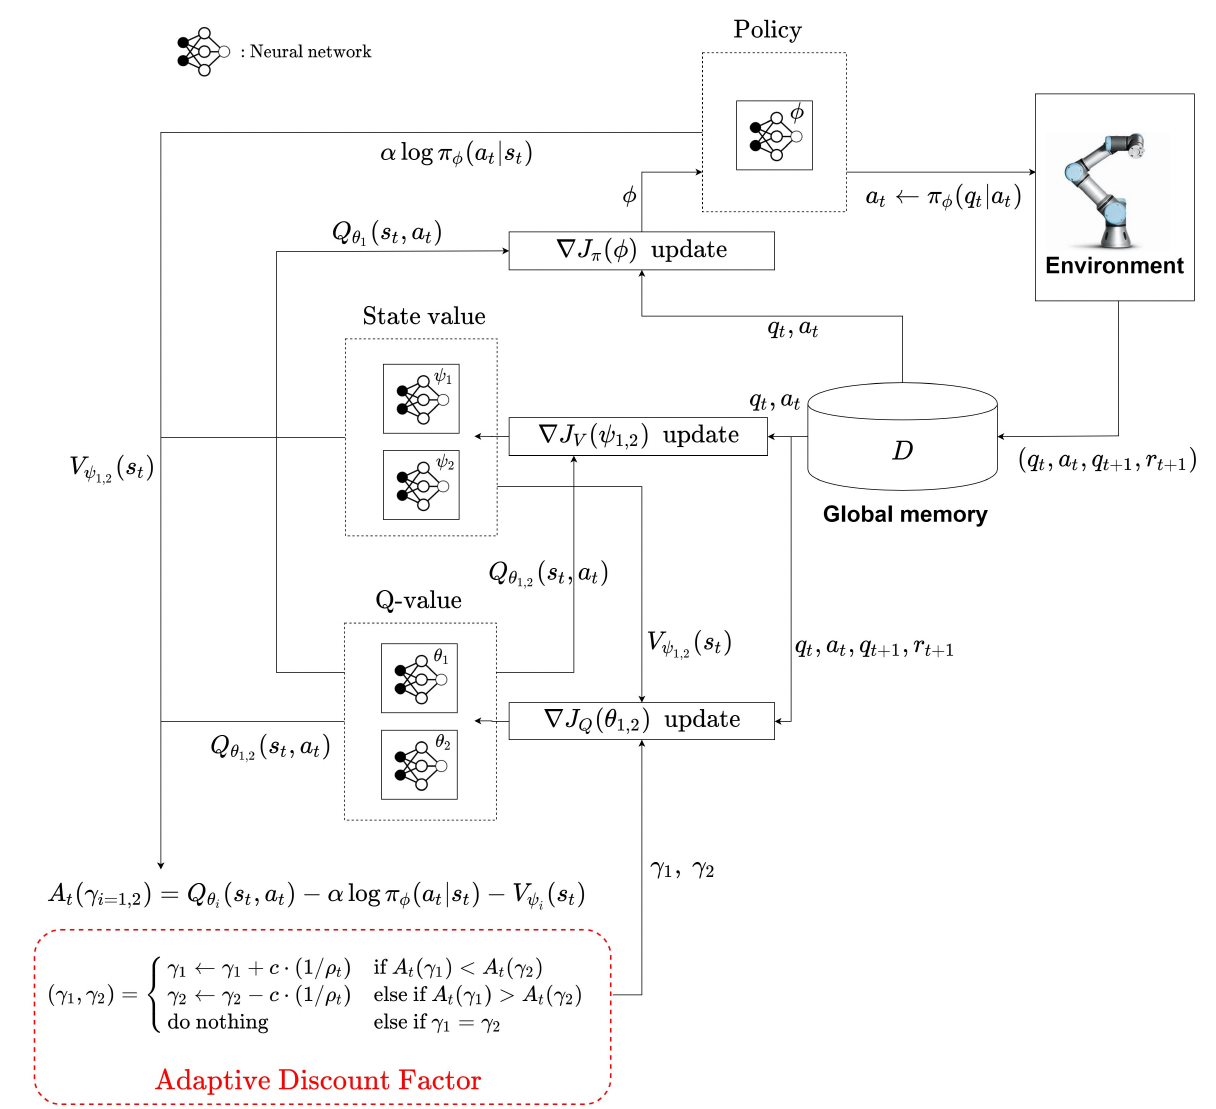
Figure 11. SAC with adaptive discount factor for robot manipulation